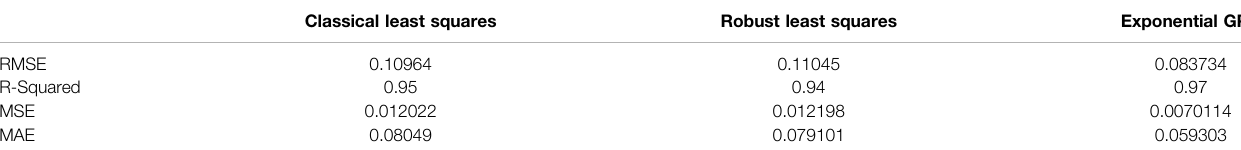
Classical least squares